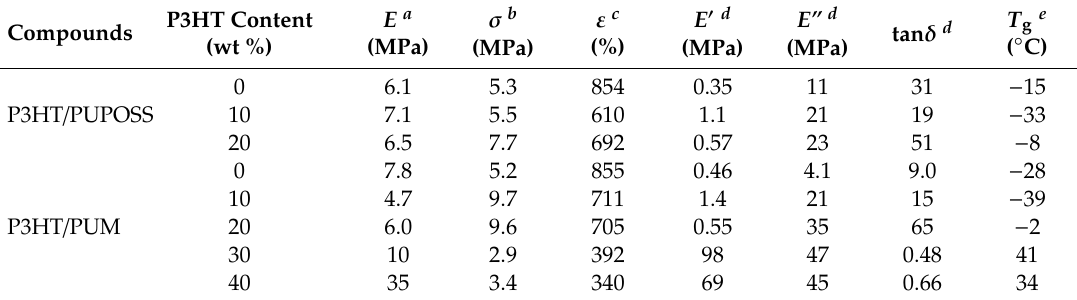
Table 1. Mechanical properties of hybrid